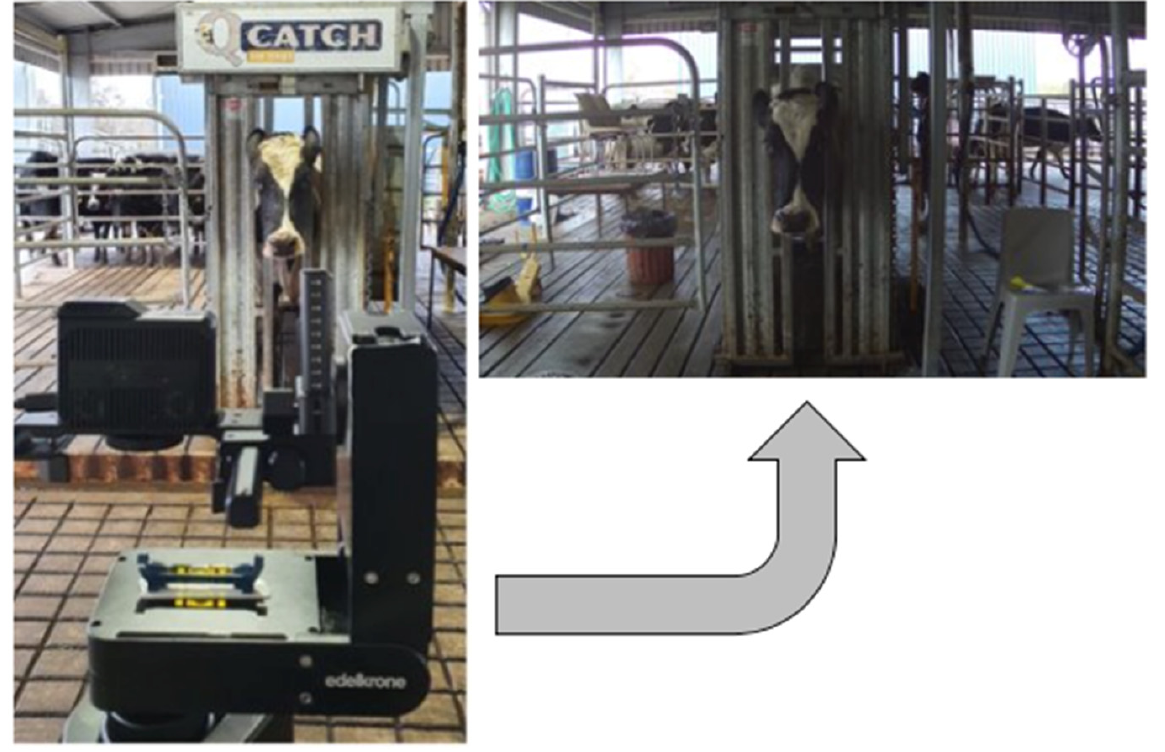
Figure 1. A sample setup of a recording session of the cattle videos.